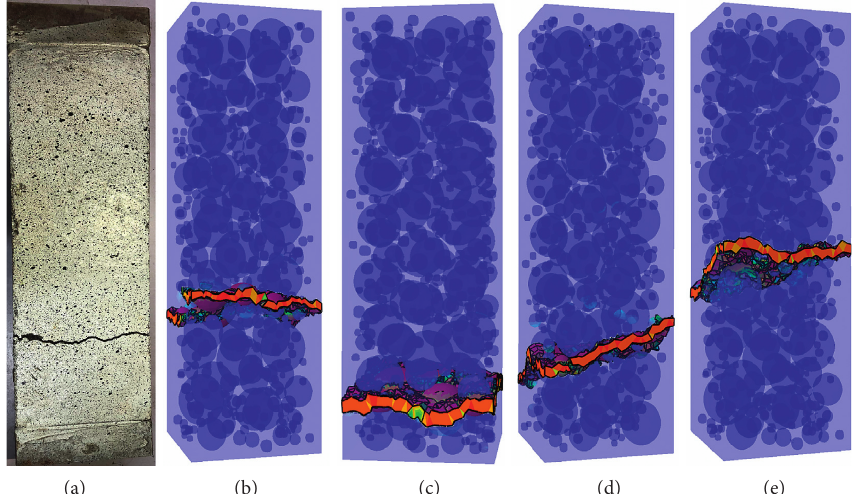
Figure 9: Crack patterns of the A-M ITZs and R-M ITZs existence study. (a) Test result. (b) ITZ_0.6_RTZ_0.6. (c) ITZ_0.6_RTZ_0. (d) ITZ_0_RTZ_0.6. (e)